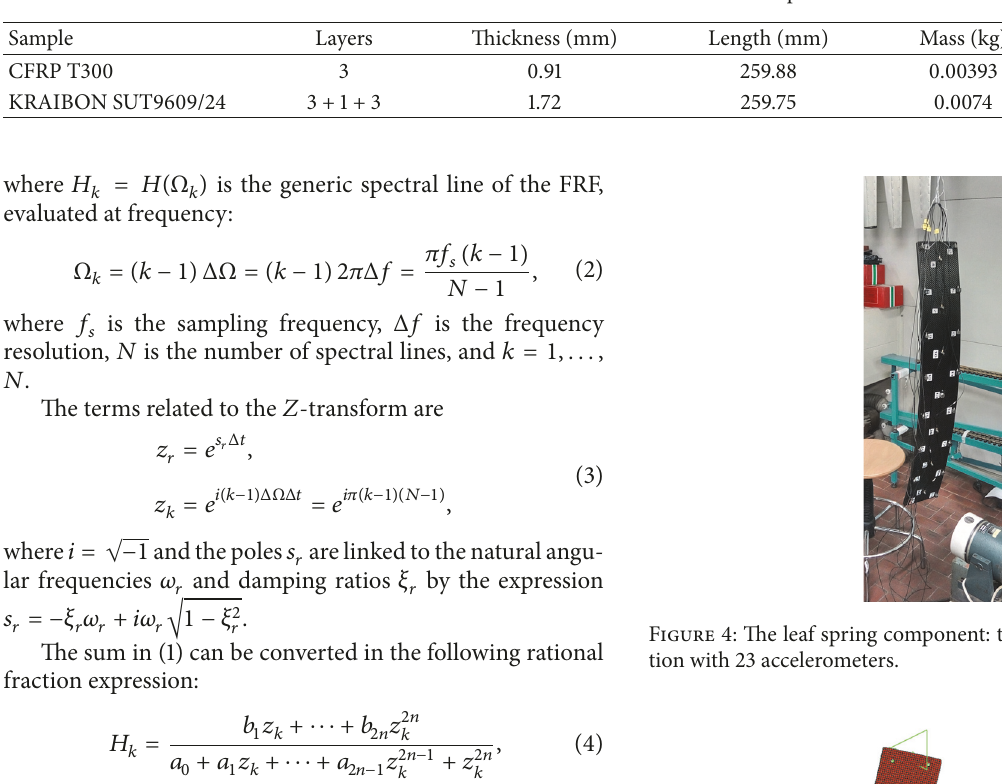
Table 1: Mean characteristics of the samples.